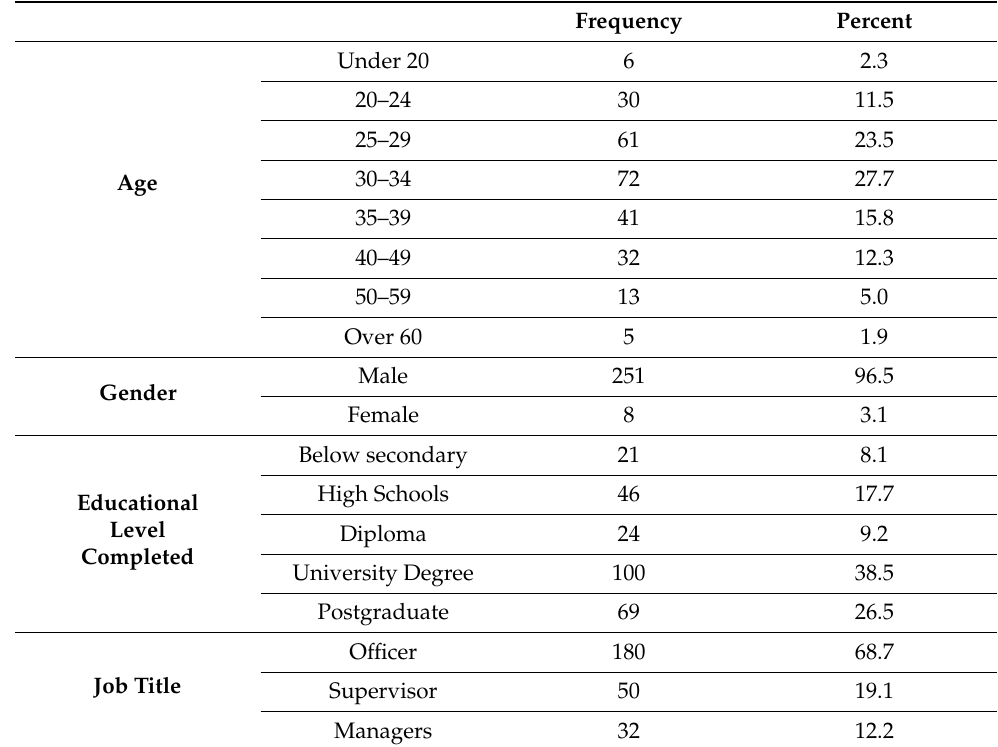
Table 2. Characteristics of the sample according to demographic